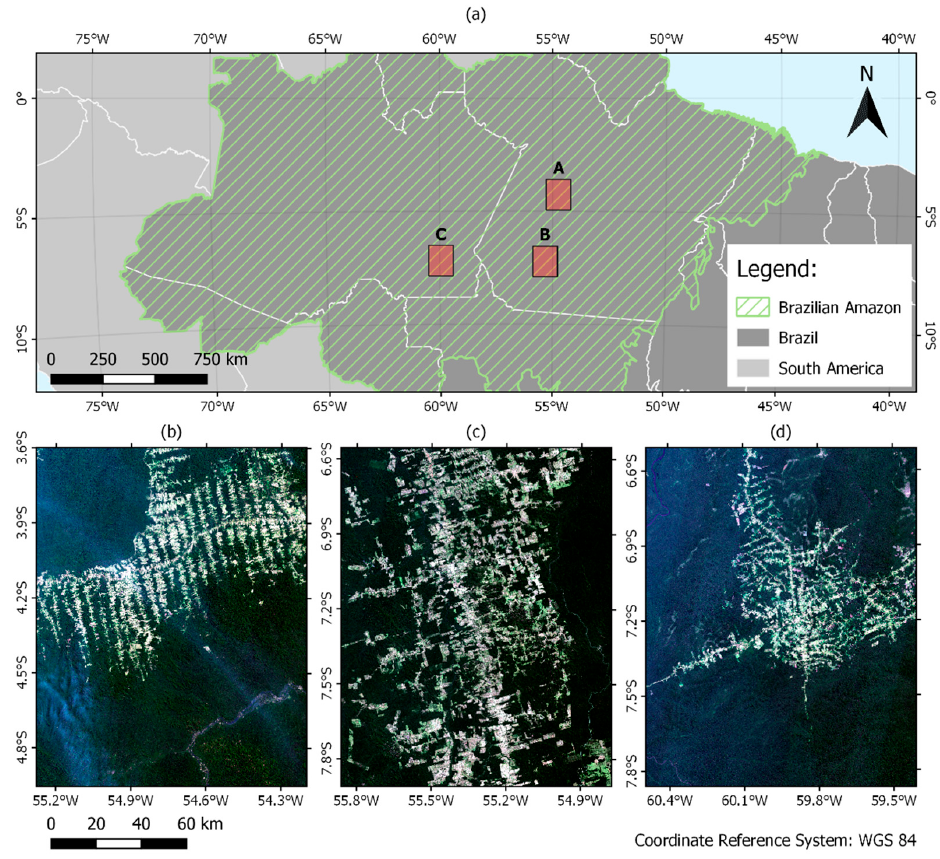
Figure 1. ( a ) Location of the study sites within the Amazon region with the ( b , c ) train sites A and B and ( d ) test site C sites A, B, and C as true color composite Landsat images taken from June (C) and July (A and B) 2018. Table 1. Acquisition dates for each site and corresponding Landsat scenes.